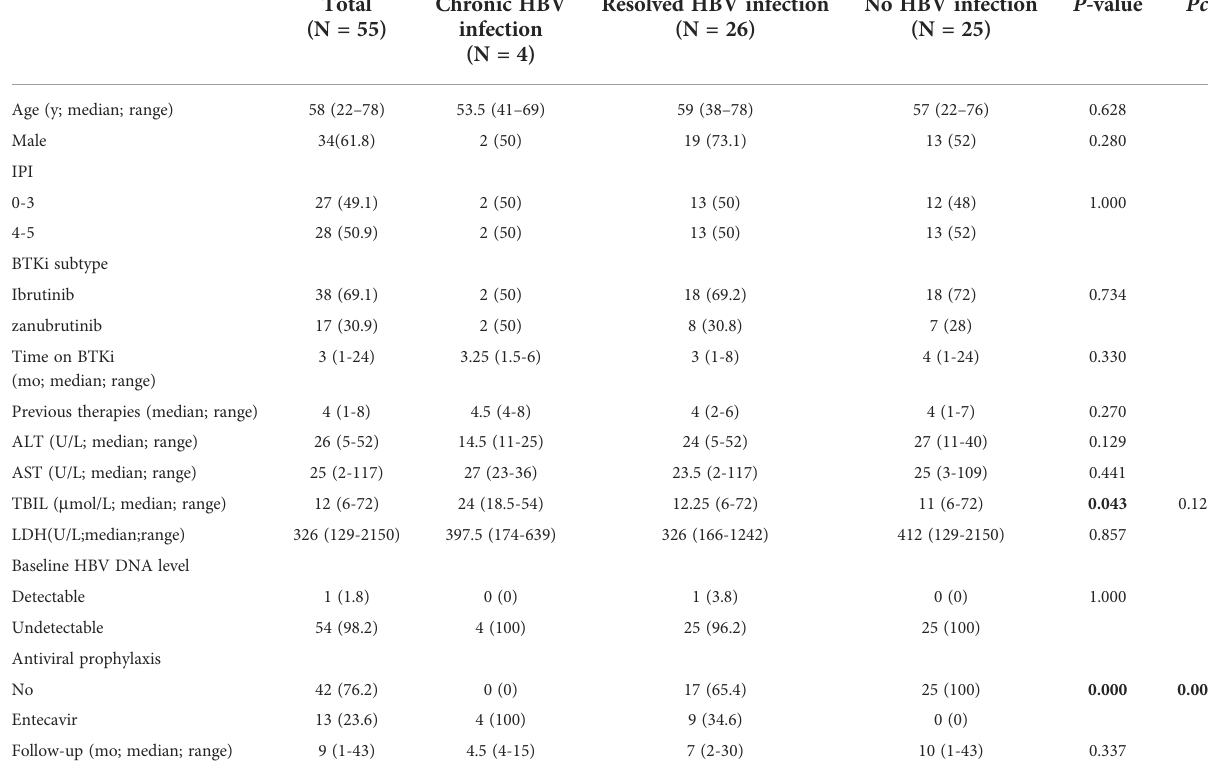
TABLE 1 Demographics and clinical characteristics of R/R DLBCL patients enrolled in the study (N = 55)